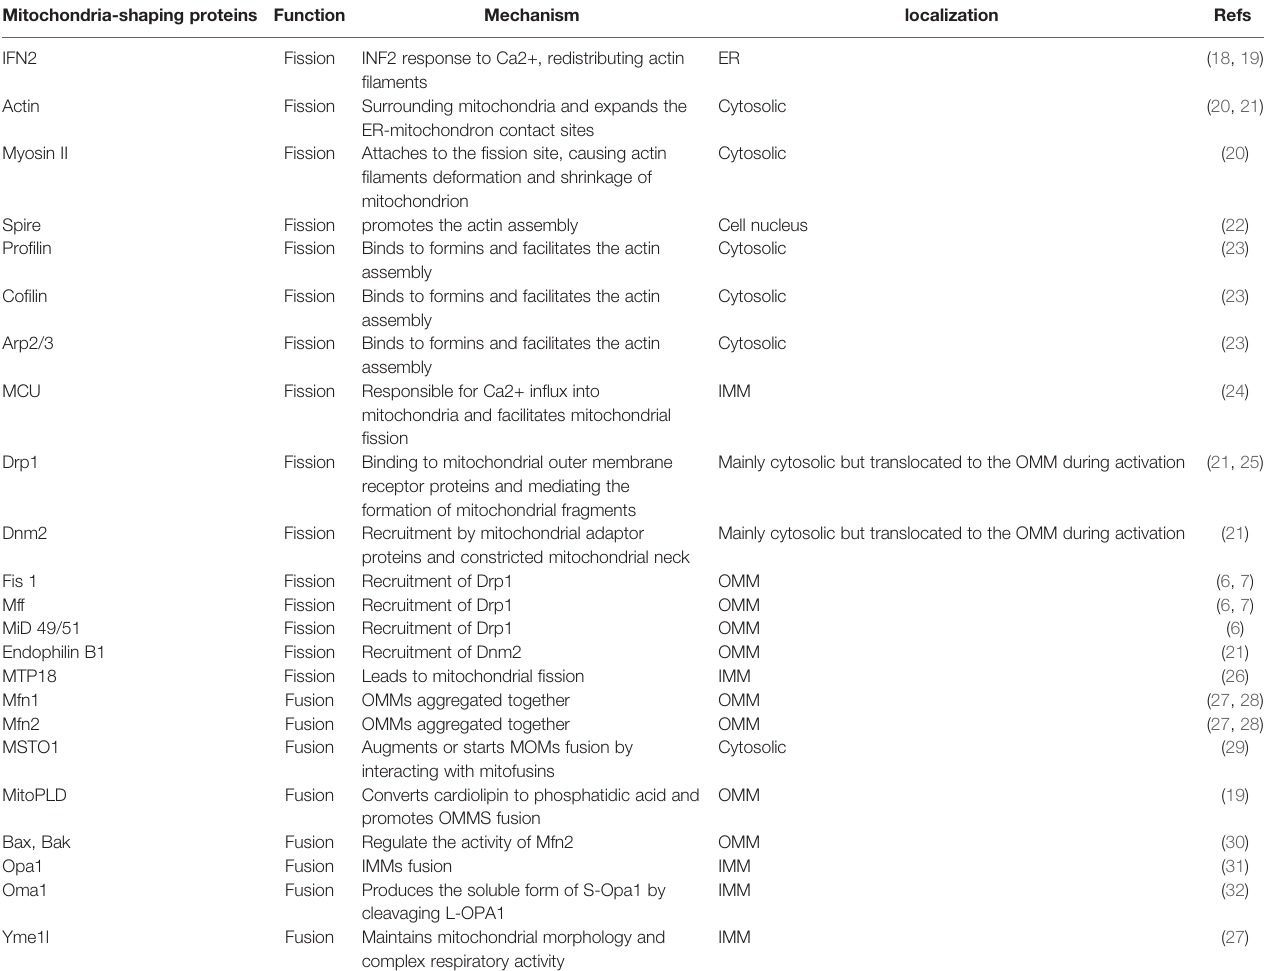
TABLE 1 | The functions of mitochondria-shaping